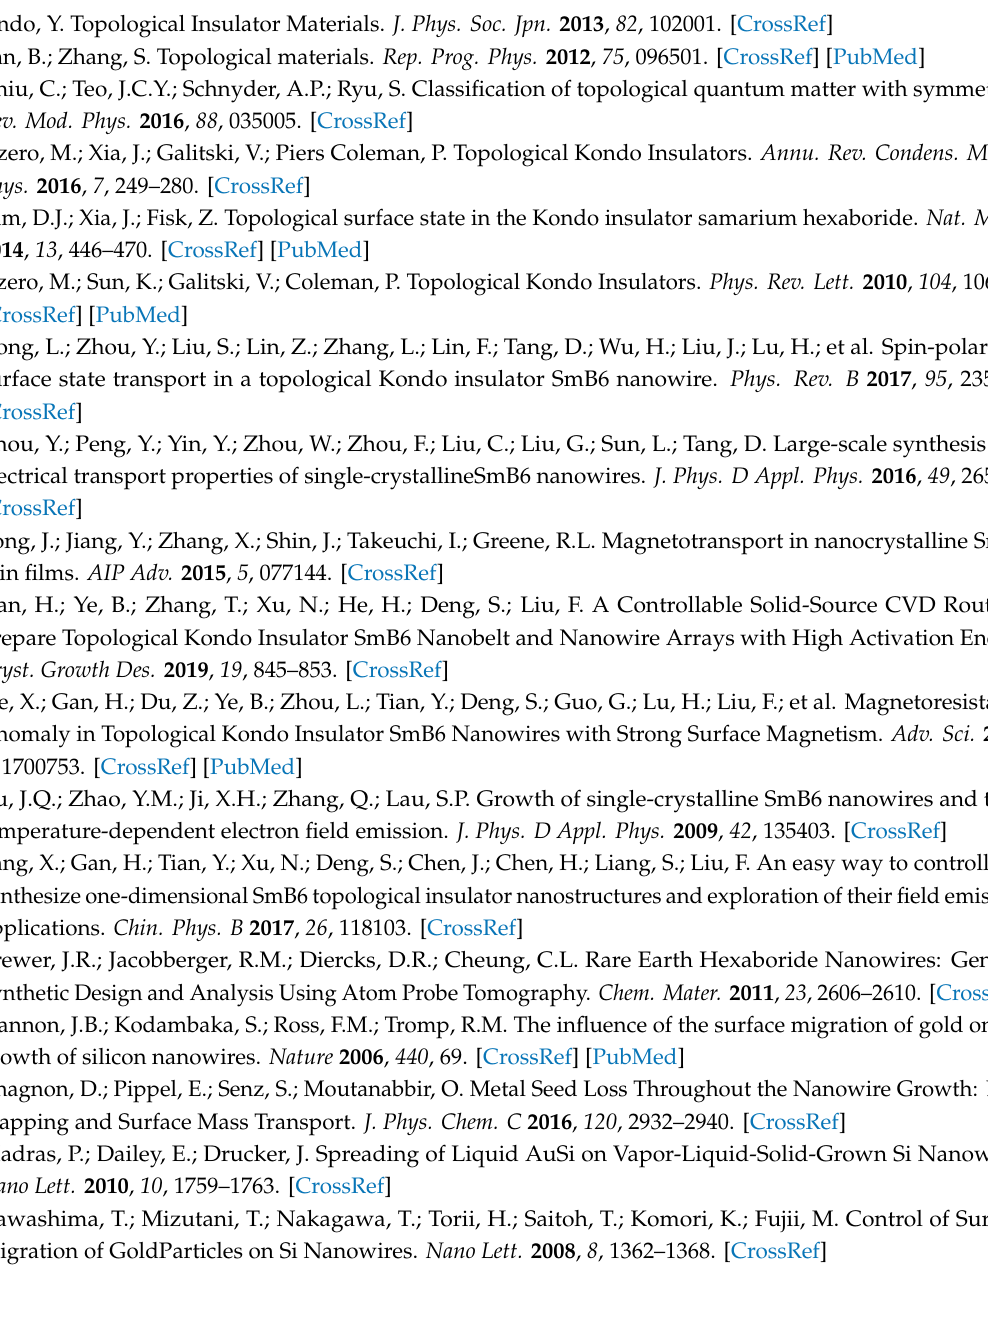
Figure S1: Schematic device structure; Figure S2: SEM image of fabricated device; Figure S3: I-V plot measured in a probe